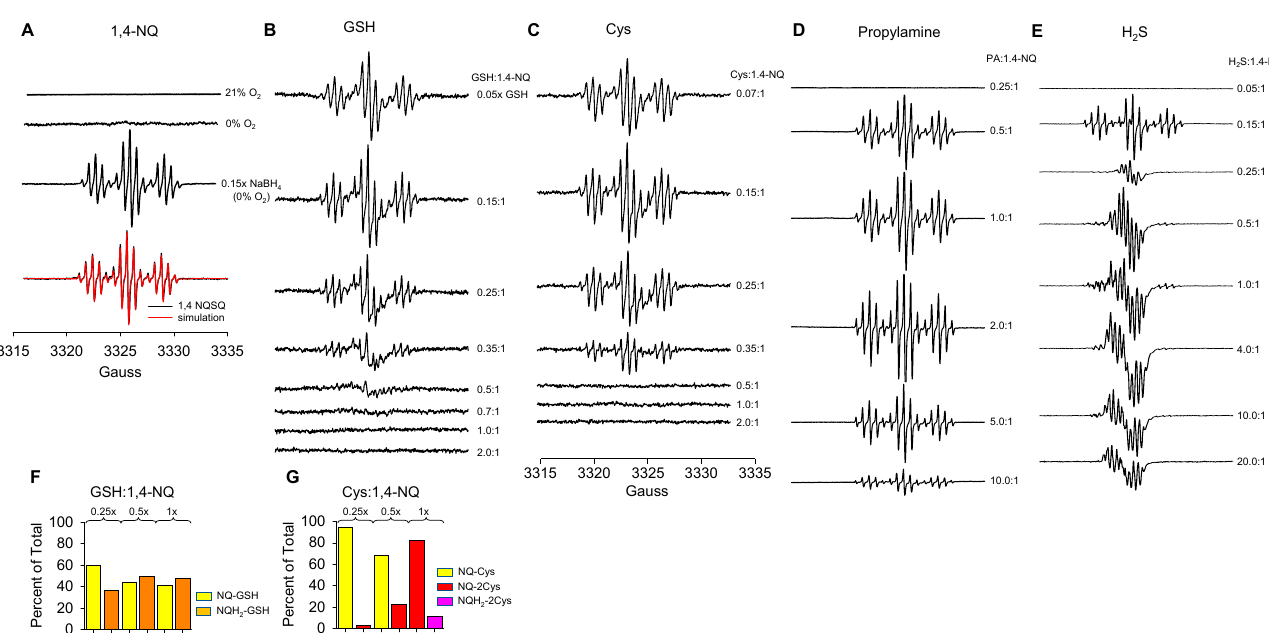
Figure 4. 1,4-NQ-GSH and 1,4-NQ-Cys adducts detected by EPR ( A – G ) and LCMS ( F , G ). ( A ) EPR spectra of 4 mM 1,4-NQ in 21% and 0% O 2 is flat, whereas reduction of 4 mM 1,4-NQ with 1 mM NaBH 4 and subsequent comproportionation produces the 1,4-NQ semiquinone that is identical to the simulated semiquinone (red trace). ( B – E ) EPR spectra of 4 mM 1,4-NQ with increasing concentrations (shown as the ratio of thiol to 1,4-NQ) of GSH ( B ), Cys ( C ), propylamine ( D ), or H 2 S ( E – G ). Spectra of GSH and Cys are similar but not identical to the 1,4-NQ semiquinone at low GSH or Cys concentrations, and the signals disappear as the ratio of GSH or Cys to 1,4-NQ approaches 0.5:1. Spectra of propylamine are identical to reduced 1,4-NQ semiquinone and persist up to a 10:1 propylamine:1,4-NQ ratio. EPR spectra of 4 mM 1,4-NQ and increasing concentrations of H 2 S are different. At a H 2 S:1,4-NQ ratio of 0.15:1, the EPR spectrum is also typical of the 1,4-NQ semiquinone, whereas the spectrum abruptly changes and becomes more complex at higher H 2 S:1,4-NQ ratios. These changes persist even at a H 2 S:1,4-NQ ratio of 20:1. ( F ) Incubation of 250 µ M, 500 µ M, and 1 mM GSH with 1 mM 1,4-NQ (0.25:1, 0.5:1 and 10:1 GSH:NQ) produced nearly equal amounts of 1,4-NQ-GSH and 1,4-NQH 2 -GSH. ( G )